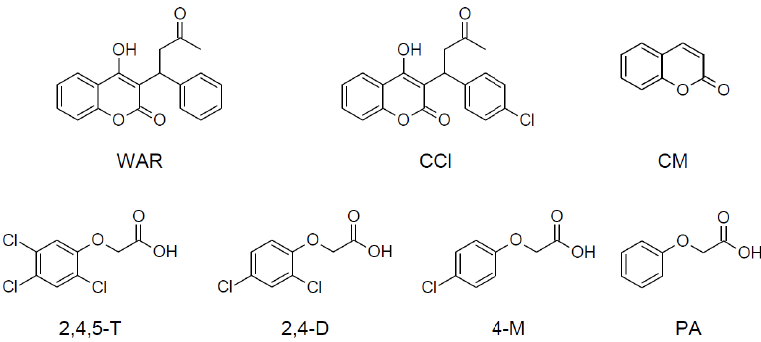
Figure 1. Structures of template molecules and related substances considered in this